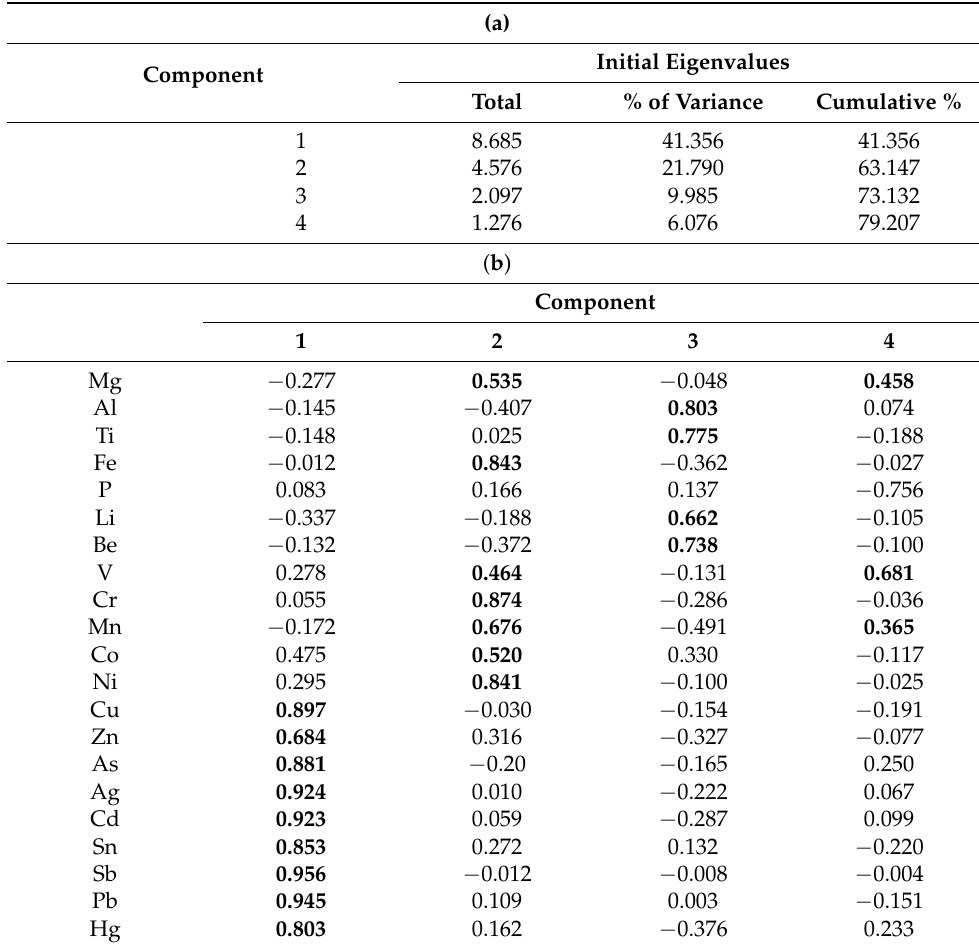
Table 6. Results extracted by principal component analysis (PCA) for the geo-accumulation index (I geo ) of PTEs in the PM10 of RDS. ( a ) Initial eigenvalues, ( b ) rotated component matrix (PCA loadings >0.5 are shown in